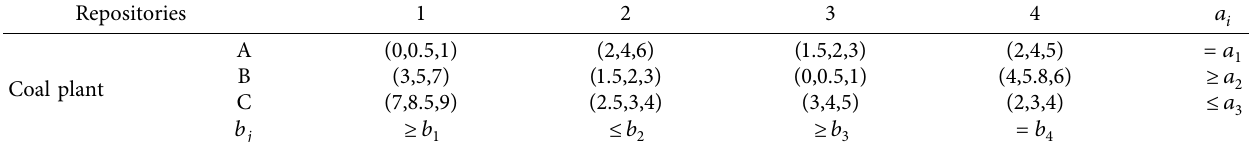
Table 2: Stochastic fuzzy transportation problem mixed constraint ( P